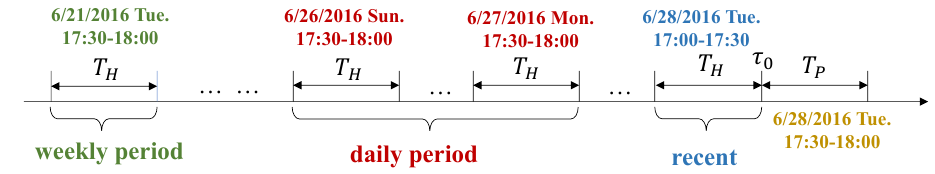
Figure 4. An example of constructing the input of time series segments (suppose the size of both historical and forecasting windows are 30